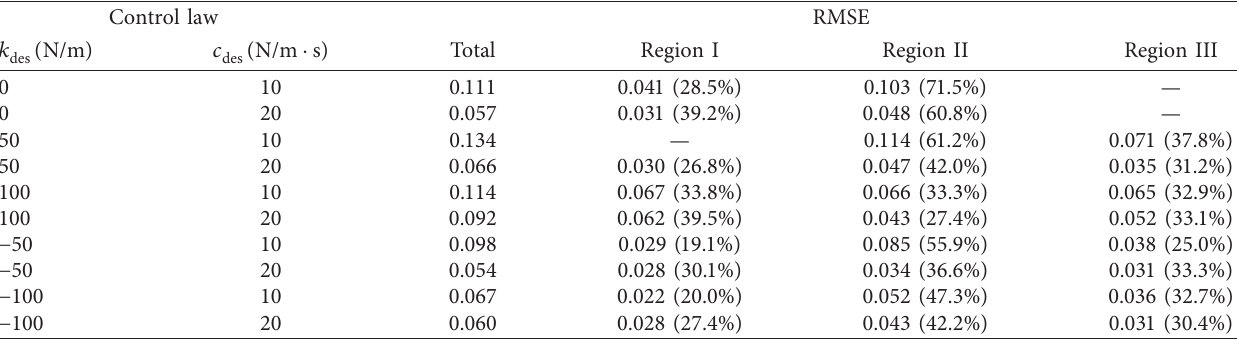
and f for different control sim act